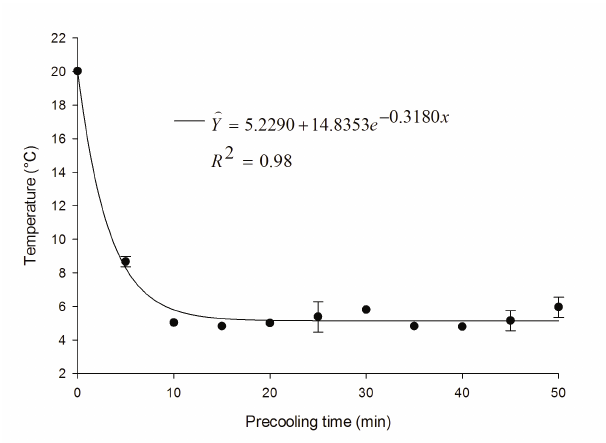
Fig. 1 - Influence of hydro cooling time period treatment on the temperature of iceberg lettuce 'Lucy